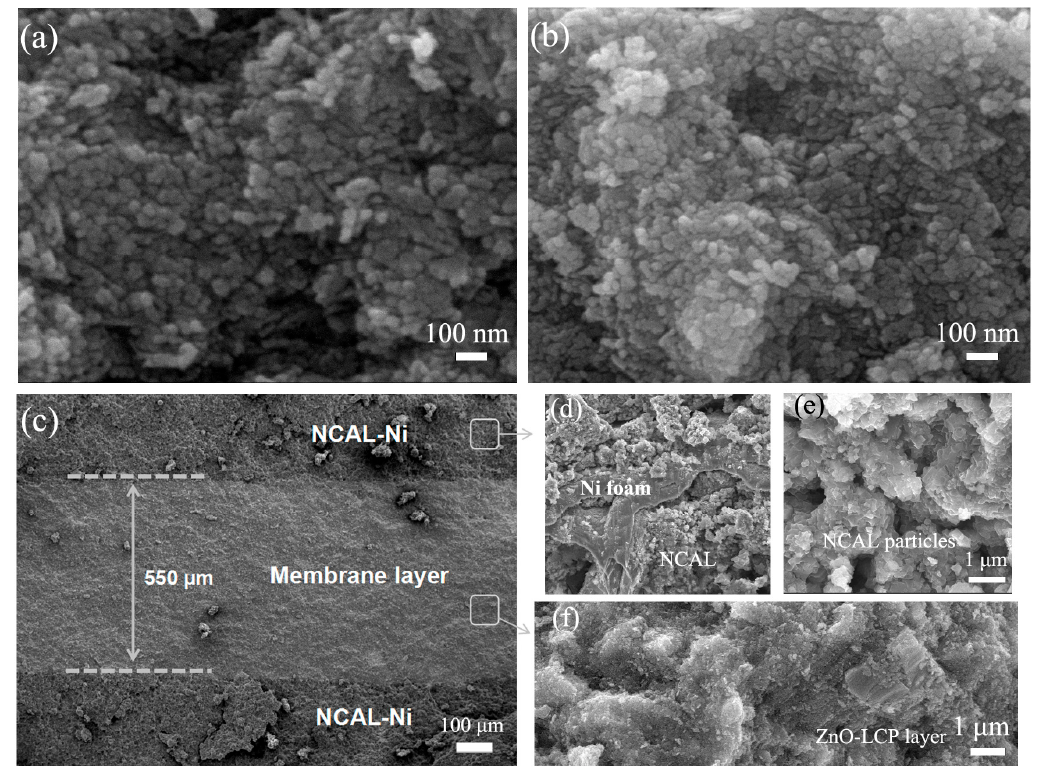
Figure 2. SEM images of ( a ) the resultant ZnO power and ( b ) ZnO-LCP composite; ( c ) Cross-sectional morphology of ZnO-LCP cell; ( d ) NCAL-Ni electrode; ( e ) NCAL particles and ( f ) the intermediate ZnO-LCP layer after operation.